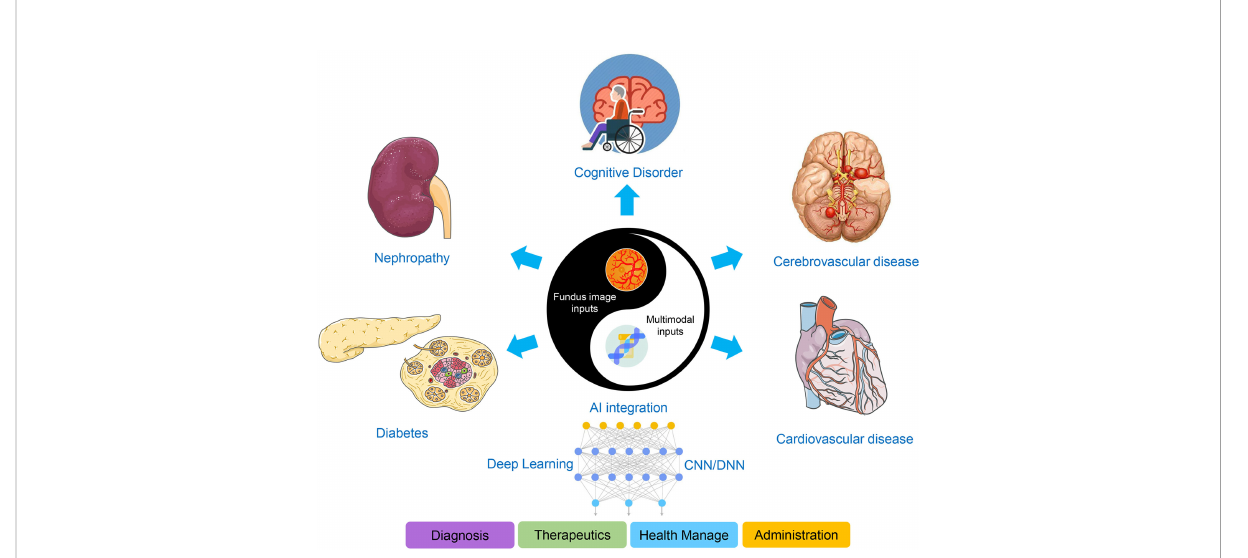
FIGURE 4 Scheme of the AI-based applications integrating DR screening with multimodal features. Fundus image inputs, including digital fundus photography and OCT, integrated with multimodal features, are indicative for diverse systemic diseases such as diabetes, nephropathy, cognitive disorder, and cerebro- or cardiovascular disease, facilitating the four perspectives of medical practice